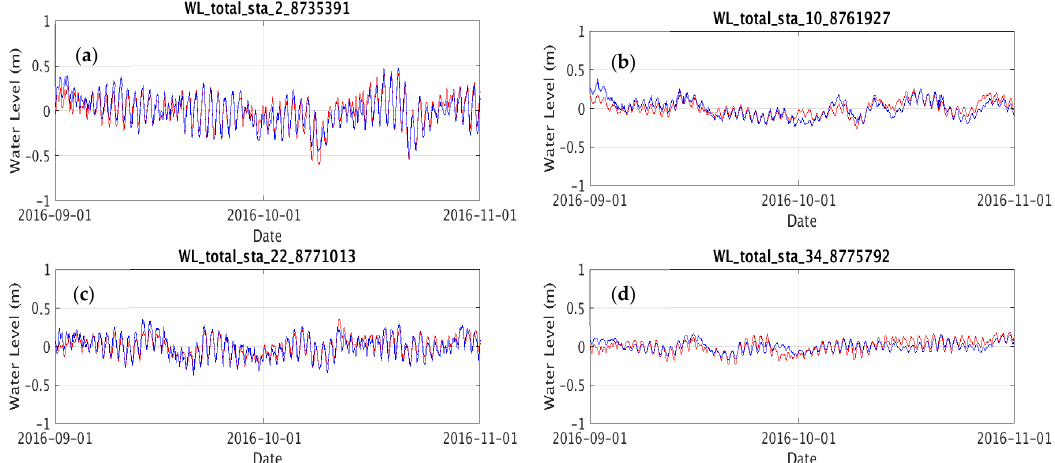
Figure 7. Comparison of model (red lines) and observed (blue lines) water levels at CO-OPS water level stations ( a ) 8735391, ( b ) 8761927, ( c ) 8771013, and ( d ) 8775792. See the station locations in Figure